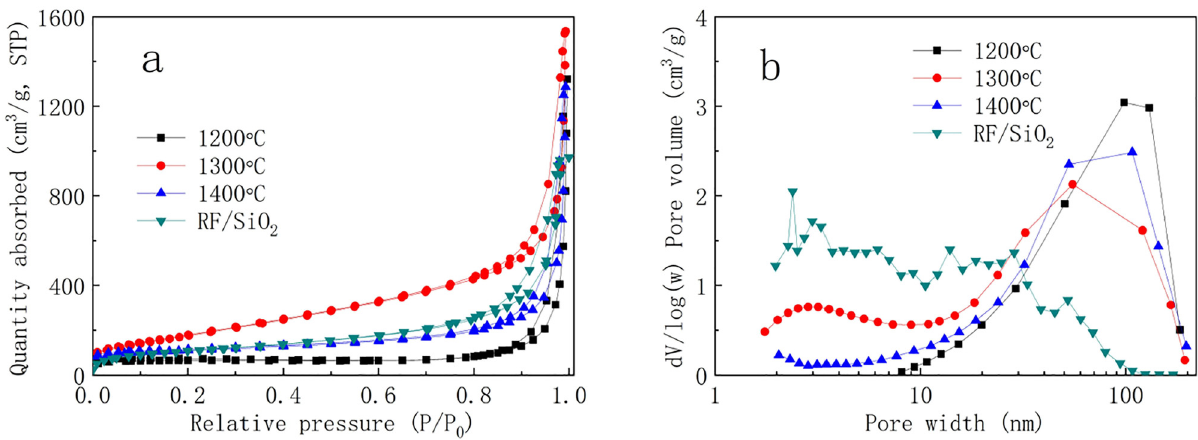
Figure 3: N 2 adsorption desorption isotherms ( a ) and pore size distribution curves ( b ) of C/SiO 2 aerogels with di ff erent heat treatment